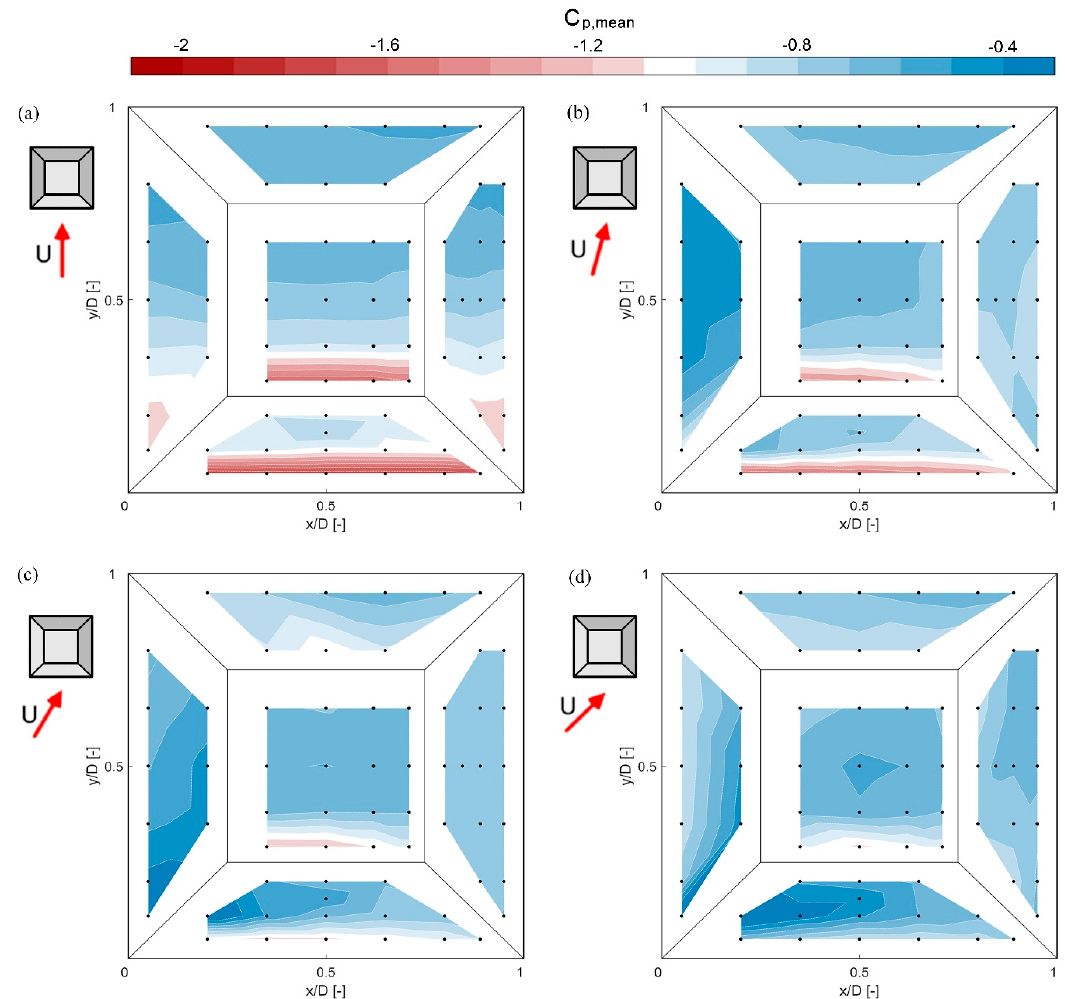
Figure 11. Mean surface pressure coefficient ( C p,mean ) distributions on the deck roof for different approaching flow angles: ( a ) 0 ◦ , ( b ) 15 ◦ , ( c ) 30 ◦ and ( d ) 45 ◦ . Black dots on the surface plot represent the measurement taps.